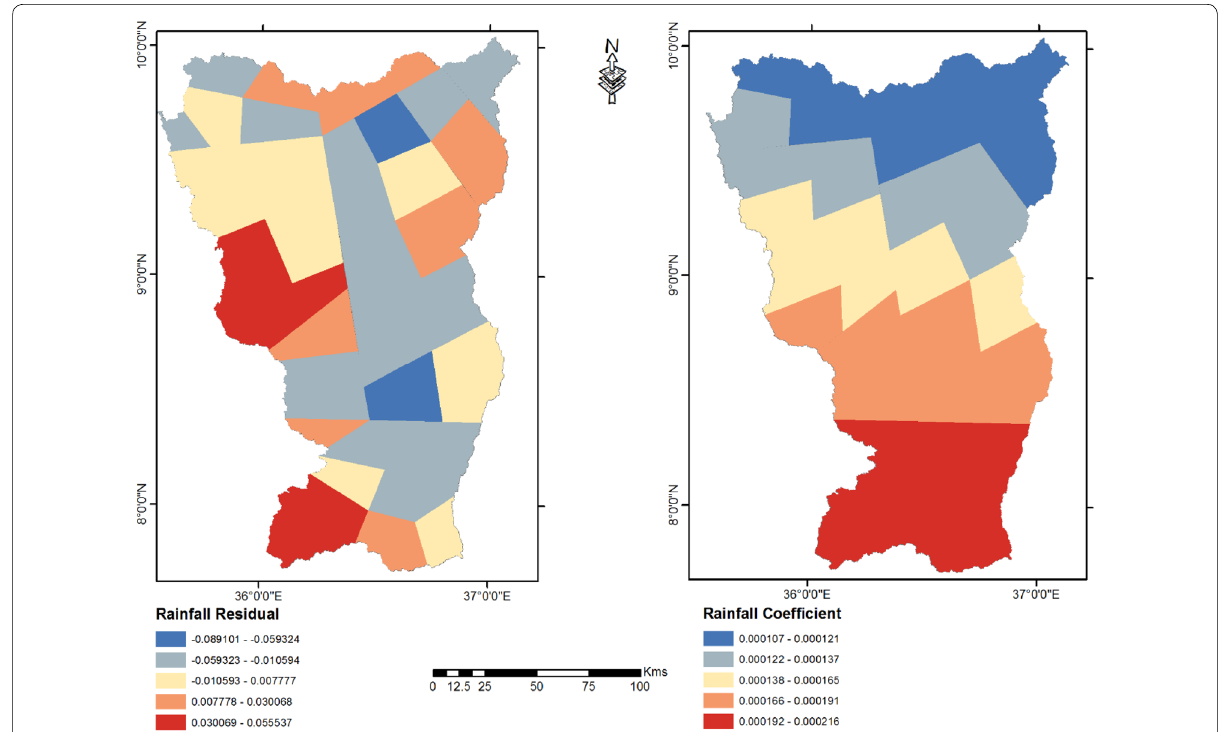
Fig. 9 GWR model residuals (right) and coefficients (left) for